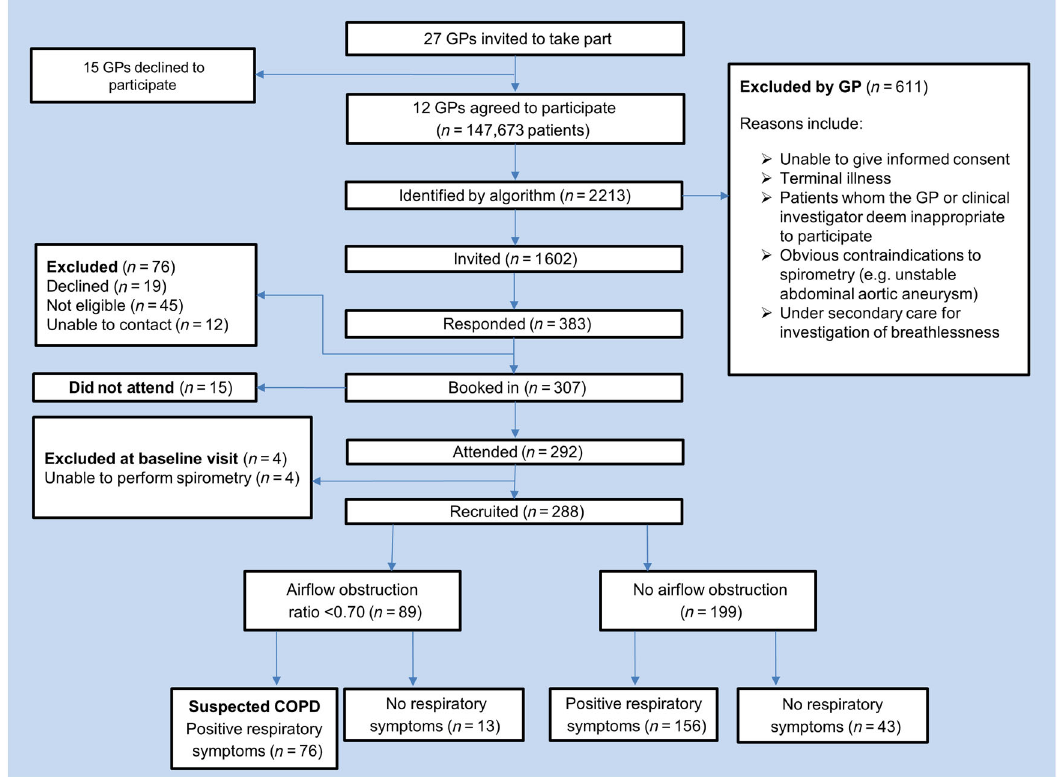
Fig. 1 Patient fl ow through the study. Indicated is the recruitment of general practices and patients. It also shows the number of GP practices that agreed to participate and the number of patients identi fi ed, invited, responded, booked and recruited. Numbers of patients determined to have air fl ow obstruction by spirometry and respiratory symptoms are also